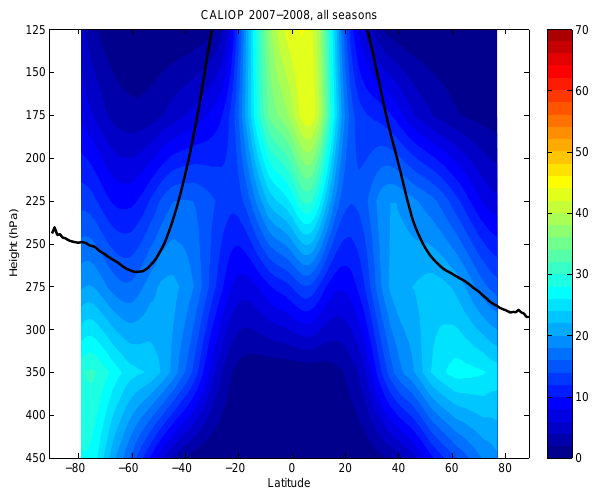
Fig. 13. Zonal means of high cloud occurrence from CALIOP for the years 2007–2008. Plain line: zonal-mean tropopause (all sea-